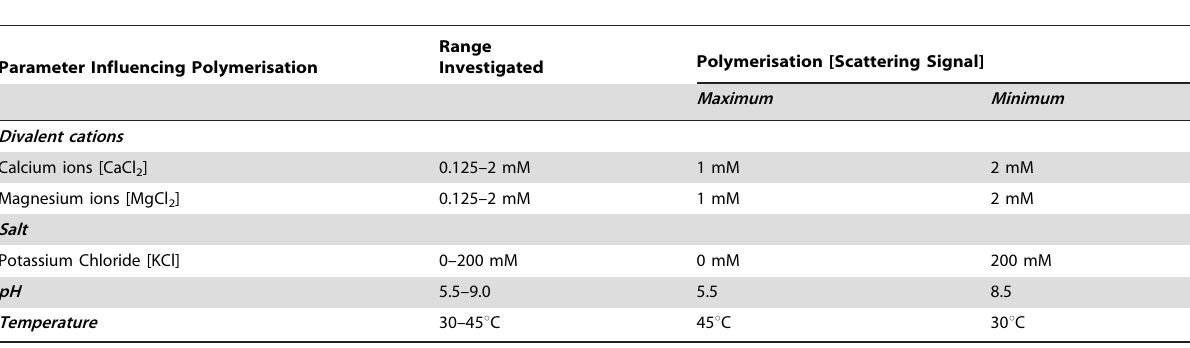
Table 1. Physico-chemical parameters influencing the polymerisation of